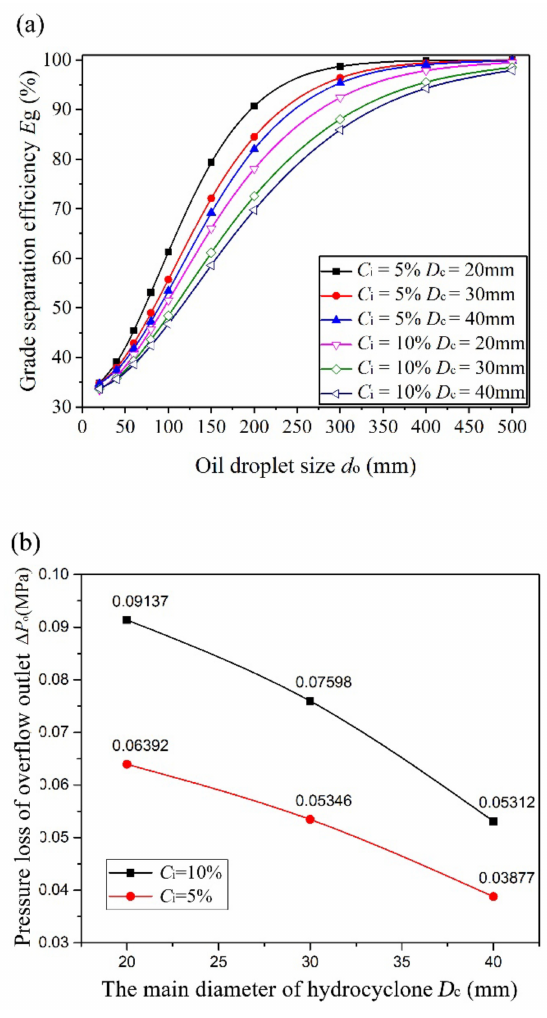
Figure 9. Comparison of grade separation efficiency and pressure loss of hydrocyclone with different main diameters for oil-water separation. ( a ) Grade separation efficiency; ( b ) Pressure